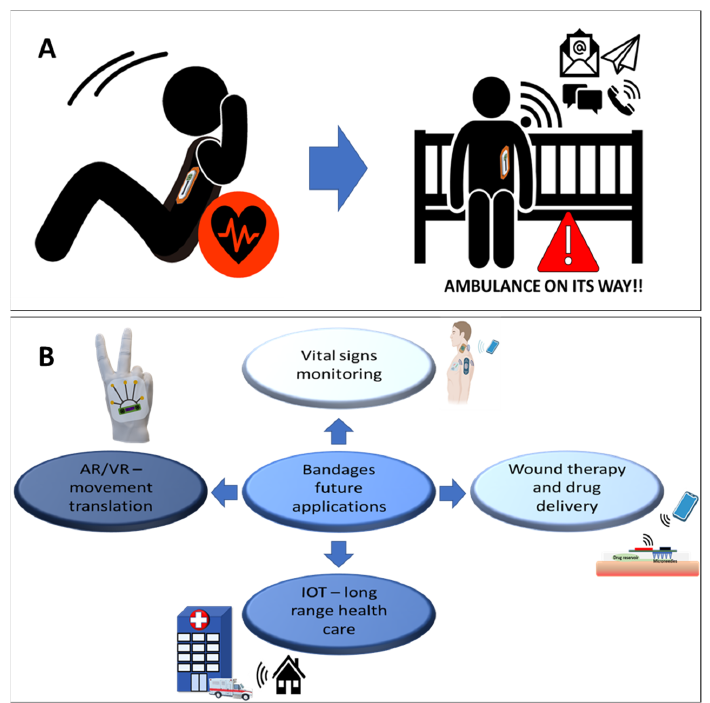
Figure 12. ( A ). Future uses of bandage-based biosensors; the smart bandage detects a physiological disorder and directly contacts the healthcare provider. Exercising person silhoue tt e